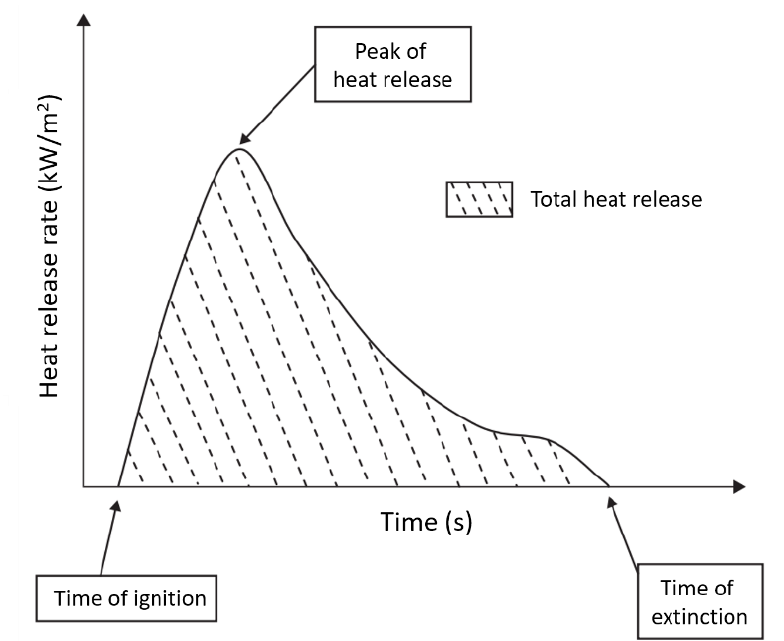
Figure 13. Typical cone calorimetry curve showing the time of ignition, time of extinction, peak heat release rate (PHRR), and total heat release (THR). Reprinted with permission from Ref. [8]. Copyright 2011, Elsevier.